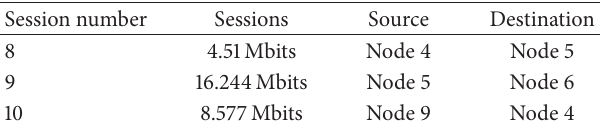
Table 7: Besides the seven sessions in Tables 5 and 6, three additional sessions are added in this